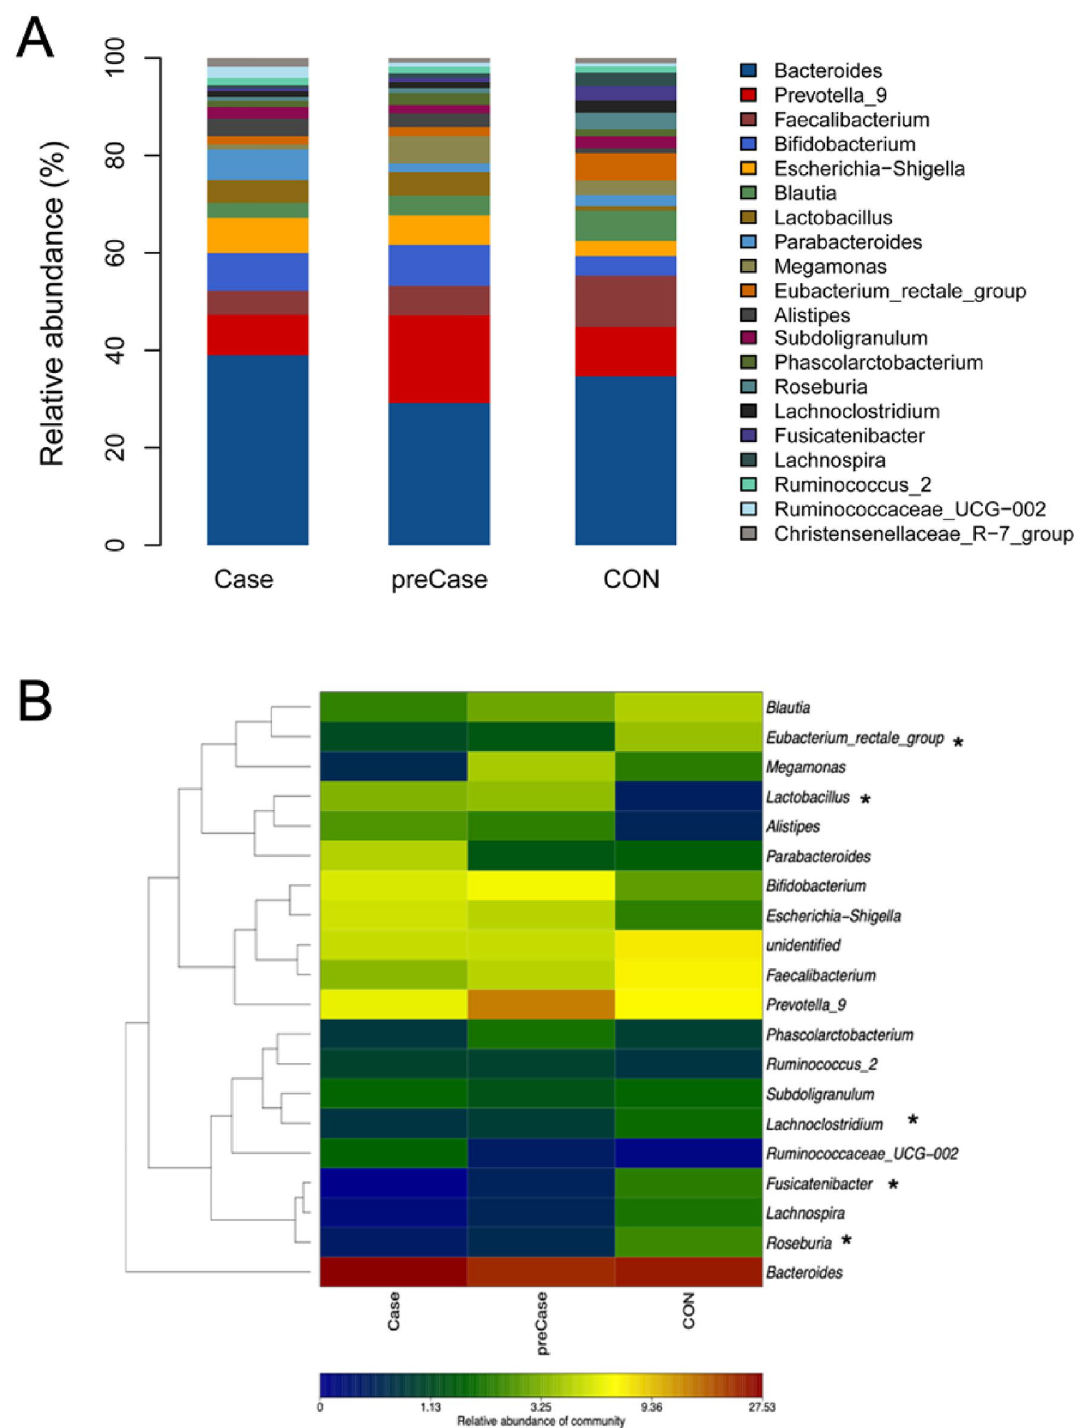
Figure 3. Taxonomic distribution of intestinal microbiota is altered in sarcopenic (Case) and possibly sarcopenic (preCase) subjects compared to healthy controls (CON). ( A ) Stacked columns for each of the groups show the mean of abundance for a given genus as a percentage of the total. ( B ) Heat map demonstrating the relative abundance of genera in each group. Wilcoxon test, * p <